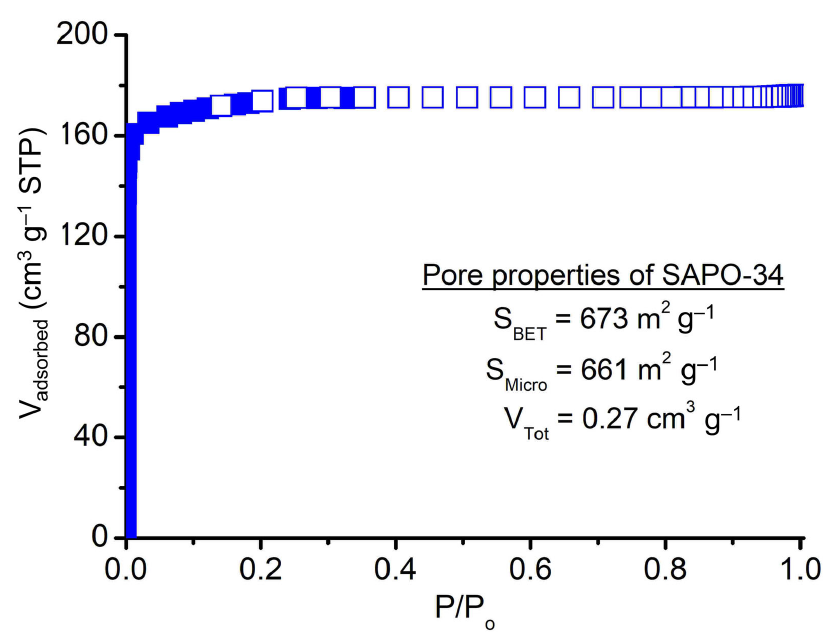
Figure 8. Nitrogen adsorption ‐ desorption isotherm of SAPO ‐ 34 (S ‐